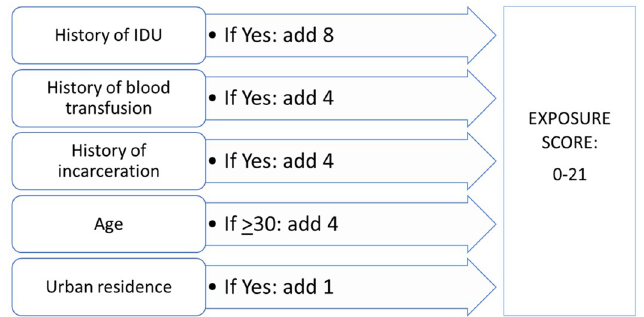
Fig 1. Calculation of HCV exposure score for males. Note : Exposure score points were assigned to each variable in the final predictive model using the following formula: parameter estimate from final predictive model multiplied by 5 and rounded to the nearest whole number. Abbreviations : HCV = hepatitis C virus, IDU = Injection drug